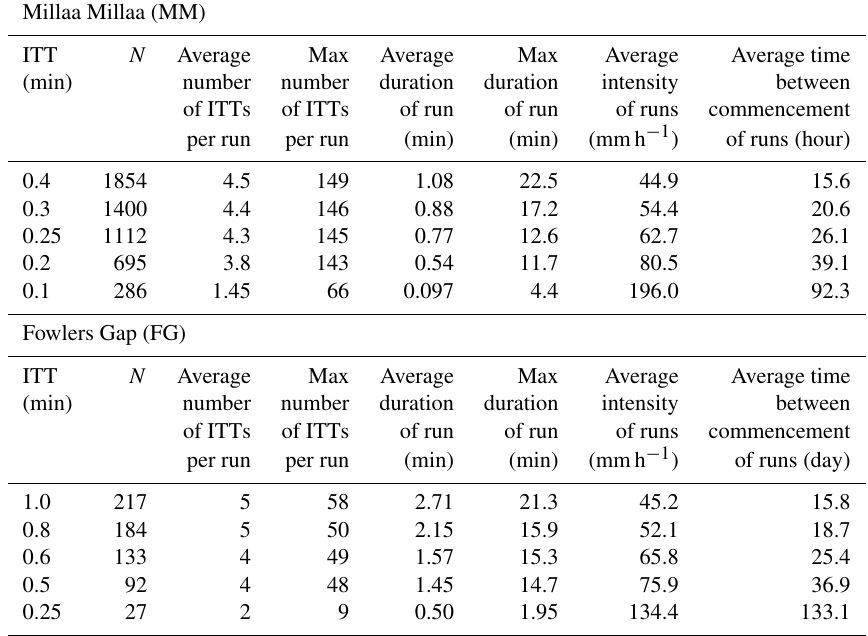
Table 2. Details of runs of short ITTs forming intensity bursts at the two field sites. The ITT values listed in column 1 were selected to represent intensities of approximately 30, 40, 50, 60, and 120mmh − 1 . The ITT durations, and the numbers of ITTs shown in column 4, differ between the sites owing to the 0.2mm sensitivity of the tipping bucket gauge at MM and the 0.5mm sensitivity at FG. Note also that the average time between the commencement of runs of short ITTs in column 8 is expressed in hours for MM but in days for